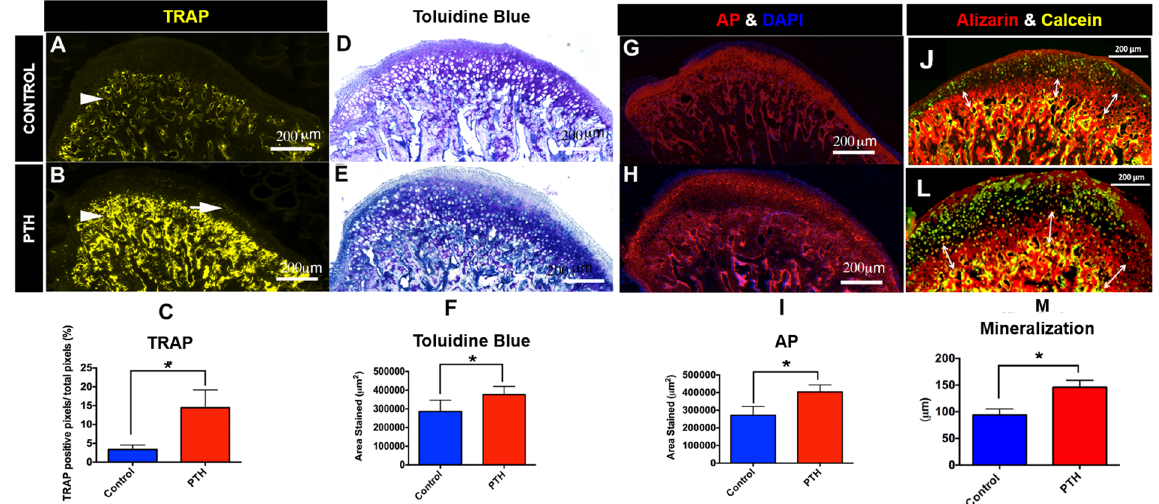
Figure 4. Increased osteoclastic activity and proteoglycan secretion with I-PTH injection. ( A ) Sagittal section stained for TRAP activity in the control group. TRAP stained cells are chiefly present in the subchondral bone (arrow head). ( B ) Sagittal section stained for TRAP activity in the experimental group (I-PTH). TRAP stained cells are present both in the subchondral bone (arrow head) and in the MCC (arrow). ( C ) Quantification of TRAP positive pixels over the subchondral bone area shows significantly increased (p < 0.05) TRAP positive pixels in the experimental group (I-PTH) (n = 5; 3 histological sections from each mouse; CI for control group: 2.63–4.08; CI for I-PTH group: 11.60–17.30). Sagittal sections stained for toluidine blue in the control ( D ) and I-PTH ( E groups. F ) Quantification shows increased (p < 0.05) toluidine blue stained area in the experimental group (I-PTH) (n = 5; 3 histological sections from each mouse; CI for control group: 251107–320973; CI for I-PTH group: 350897–401743). Sagittal sections stained for alkaline phosphatase activity in the control ( G ) and I-PTH ( H ) groups. ( I ) Quantification shows increased (p < 0.05) alkaline phosphatase stained area in the experimental group (I-PTH) (n = 5; 3 histological sections from each mouse; CI for control group: 243026– 300483; CI for PTH group: 380180–426889). Alizarin complexone and calcein labeling in sagittal sections of control ( J ) and I-PTH ( L ) groups. Histogram represents distance between calcein and alizarin complexone labels. Increased (p < 0.05) labeling was seen in the I-PTH group. * Statistically s ignificant difference between the control and I-PTH groups.